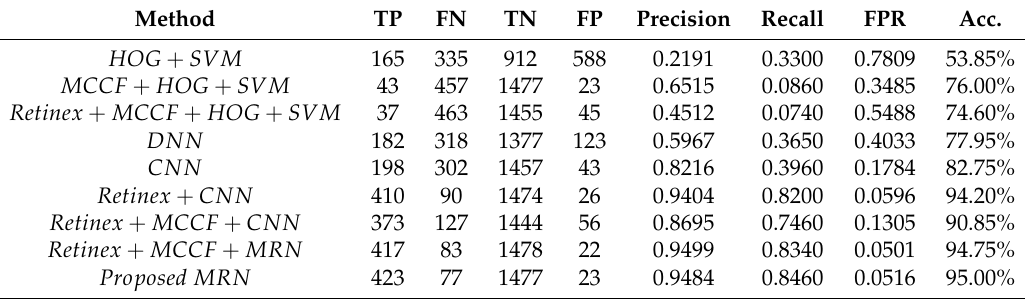
Table 1. Quantitative comparison with state-of-the art